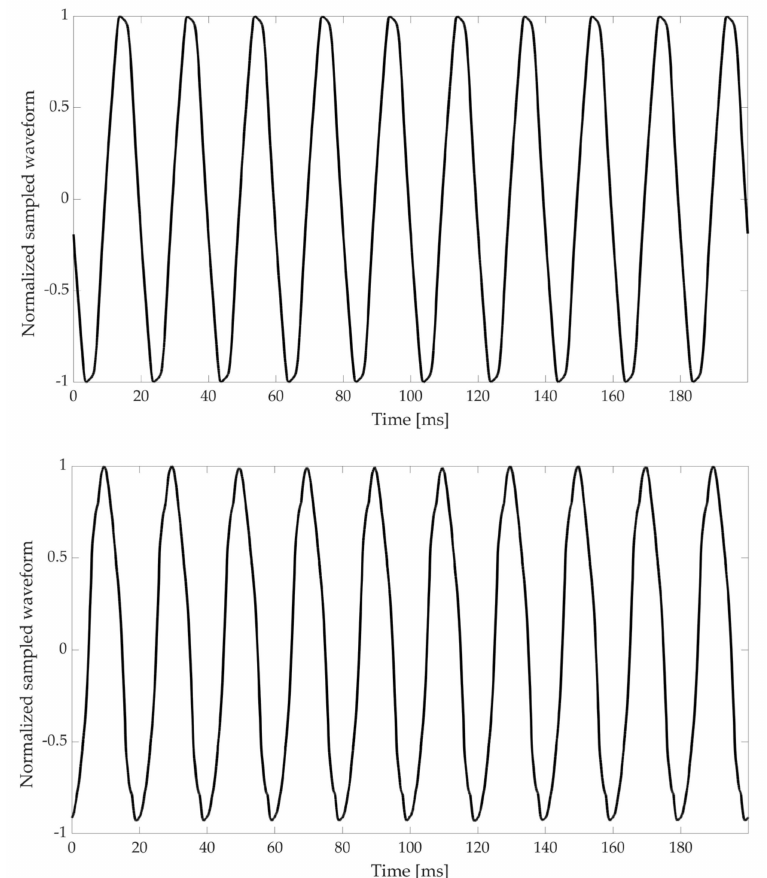
Figure 2. Waveform of the signal A ( top ) and E ( bottom ). The two sampled waveforms are normalized to